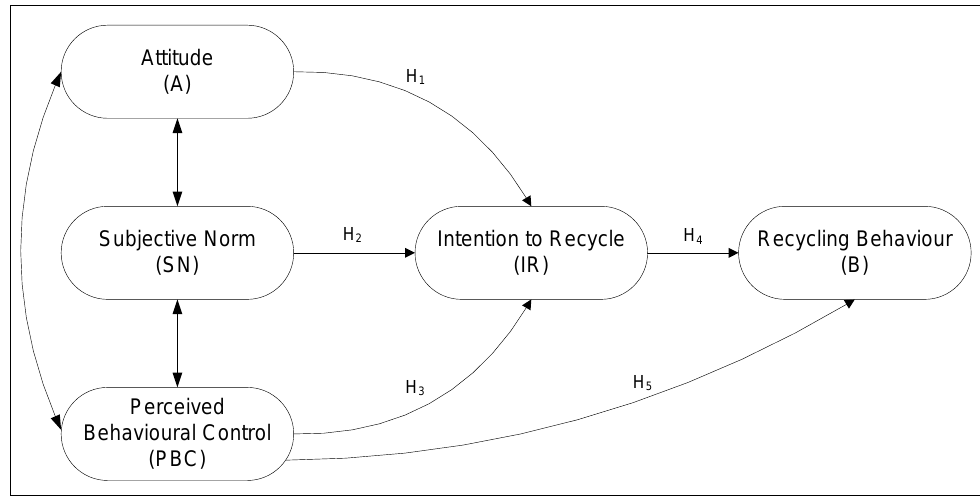
Figure 1. The Theory of Planned Behavior (adapted from Azjen & Madden, 1986 [42]).